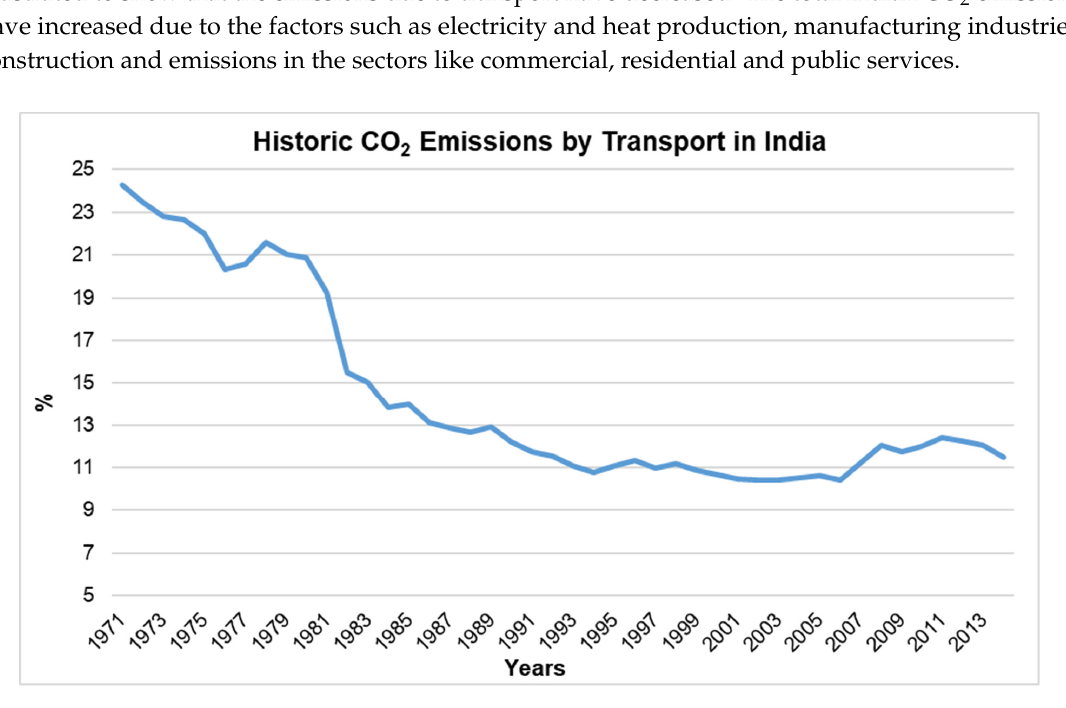
Figure 7. CO 2 Emission Predictions for India.